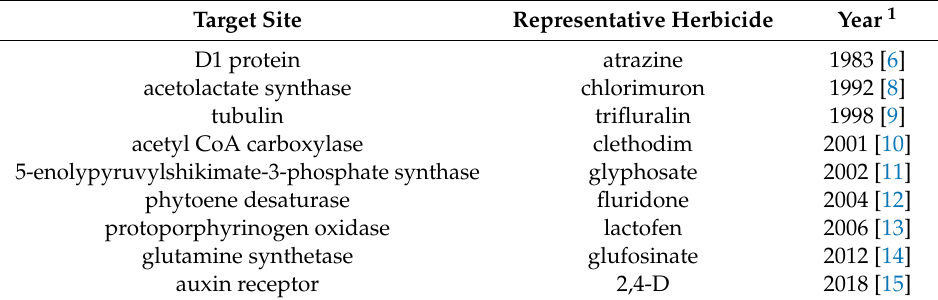
Table 1. Identification of mutations conferring target-site resistance to